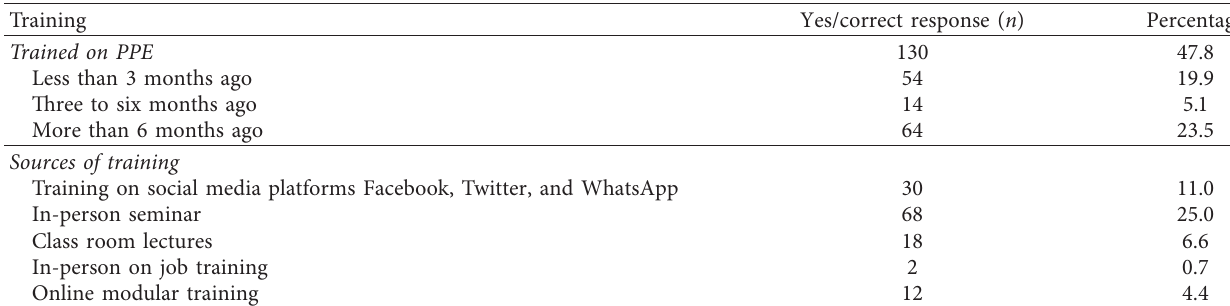
Table 4: Training of respondents on